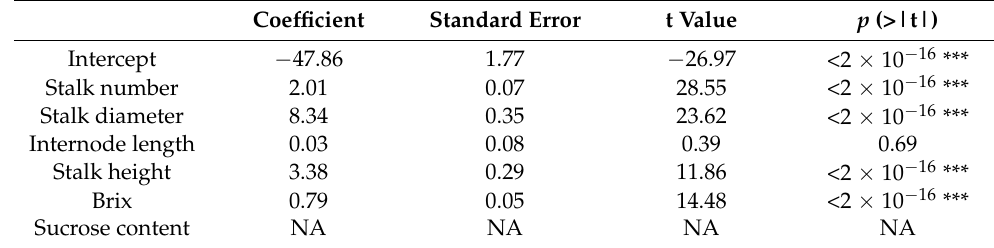
Table 4. Linear-regression analysis between sucrose yield and six related traits.